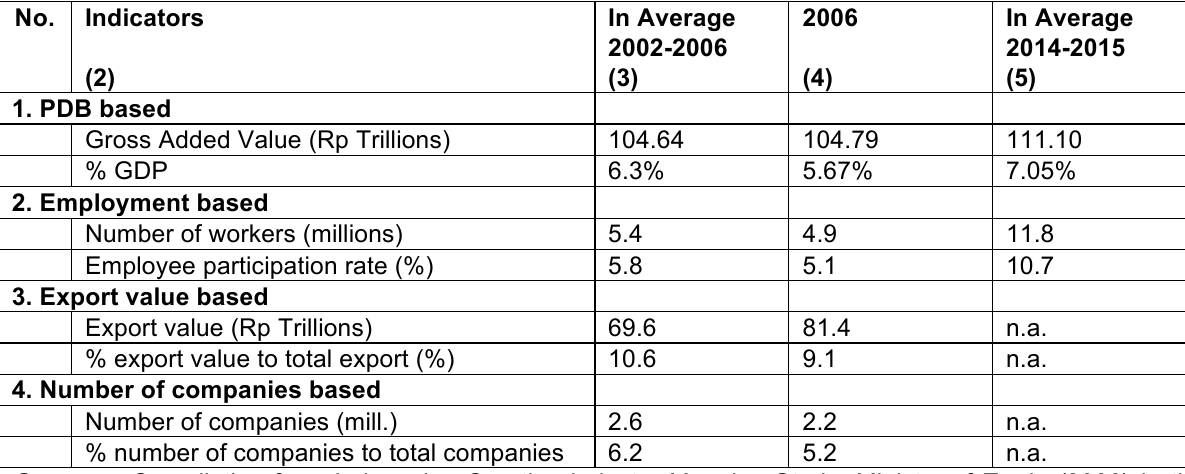
Table 2: The Indonesian Creative Industry Profile - Past and